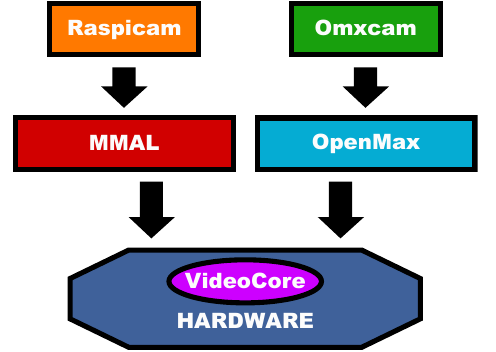
Figure 4. Diagram representing the different APIs and libraries for controlling cameras on the Raspberry